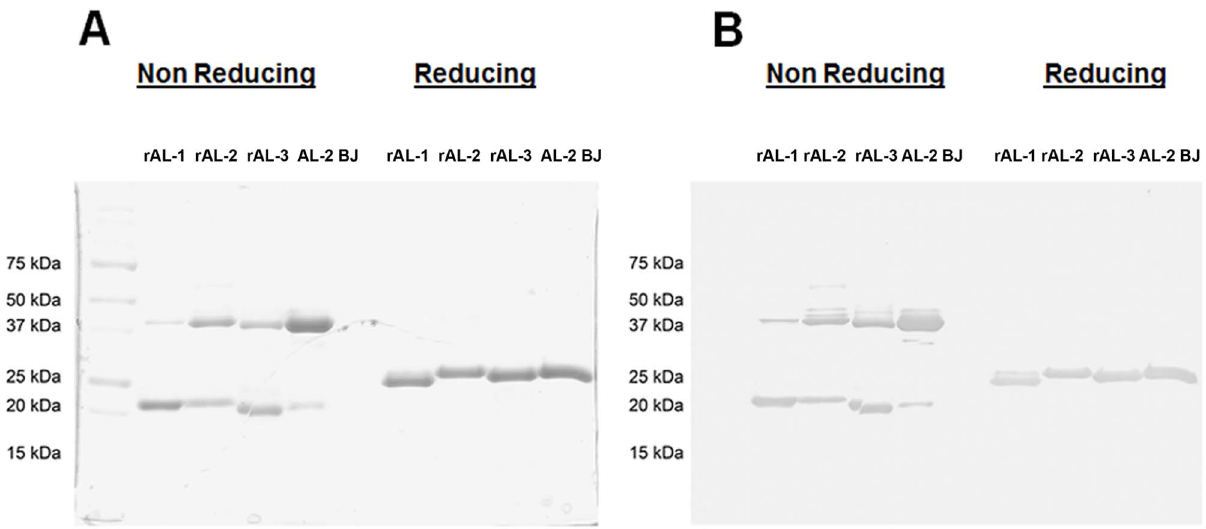
Figure 3. SDS–PAGE analysis of the purified rLC. Coomassie Brilliant Blue staining (A) and western blotting (B) analysis of purified rLC compared to AL-2 Bence Jones protein (AL-2 BJ), purified from urine. Protein samples (5 m g loaded) were resolved on 12% SDS-PAGE run under non reducing and reducing conditions. Western blot analysis was performed using a rabbit anti-human l LC antiserum as primary antibody (Dako Cytomation, Glostrup, Denmark), revealed by a goat anti-rabbit conjugated with horseradish peroxidase (Dako Cytomation), probed with diaminobenzidine (DAB) substrate. Molecular mass markers are shown in the left lane. The proteins presented the typical dimeric-monomeric species of free LC. Different degrees of protein denaturation are responsible of the minor differences in electrophoretic migration of monoclonal free LC (A), a common finding in SDS PAGE running under denaturing conditions of these proteins.